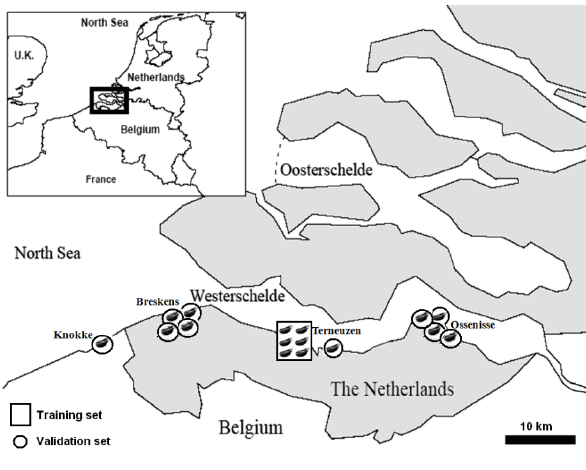
Fig. 1. Geographical position of the study sites in the Scheldt Estuary. Boxed: six shells from Terneuzen were used for training the models. Circled: the shells used for